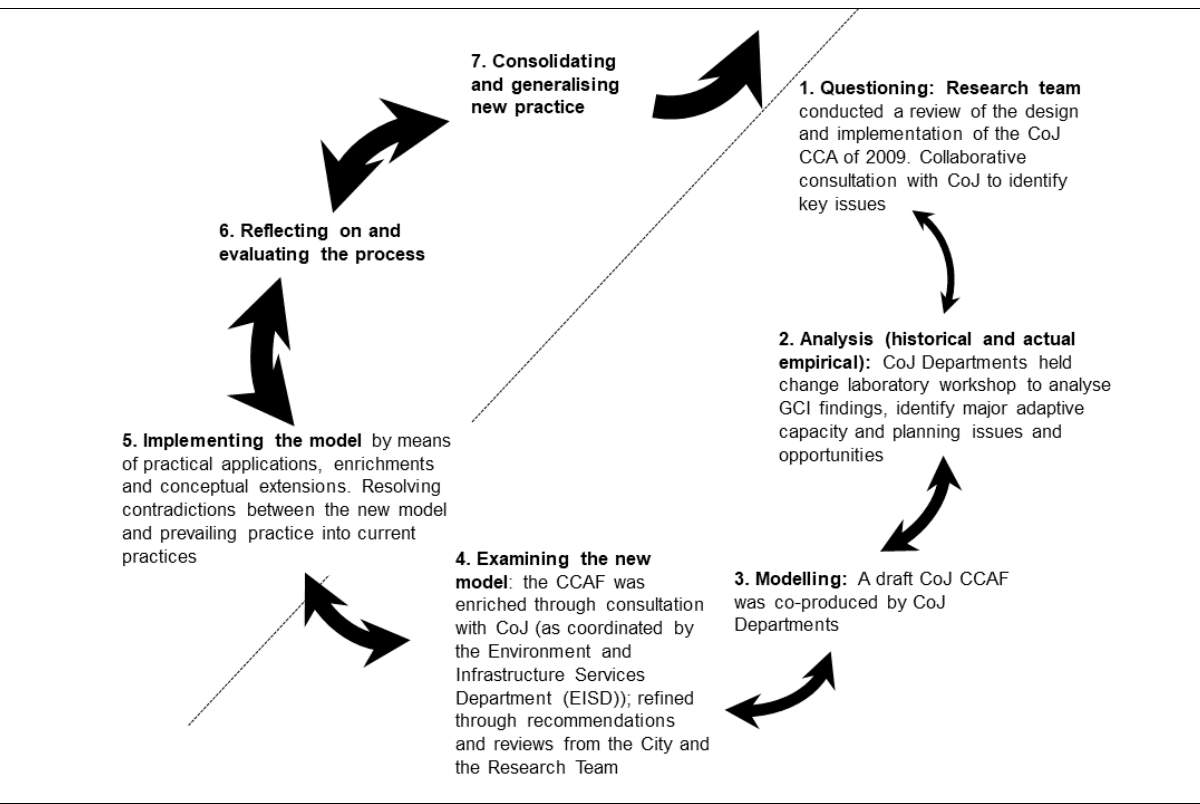
Figure 3: Expansive learning actions as applied in the City of Johannesburg’s (CoJ) Climate Adaptation Framework (CCAF) development (adapted from Engeström and Sannino 9 ). In the context of the results presented here, the development of the CCAF addressed epistemic learning actions 1–4. Actions 5–7 were still ongoing actvities at the time of writing this paper. Arrow thickness reflects scope for and level of participation in each action. CCA = Climate Change Adaptation Plan; GCI = Global Change Institute.